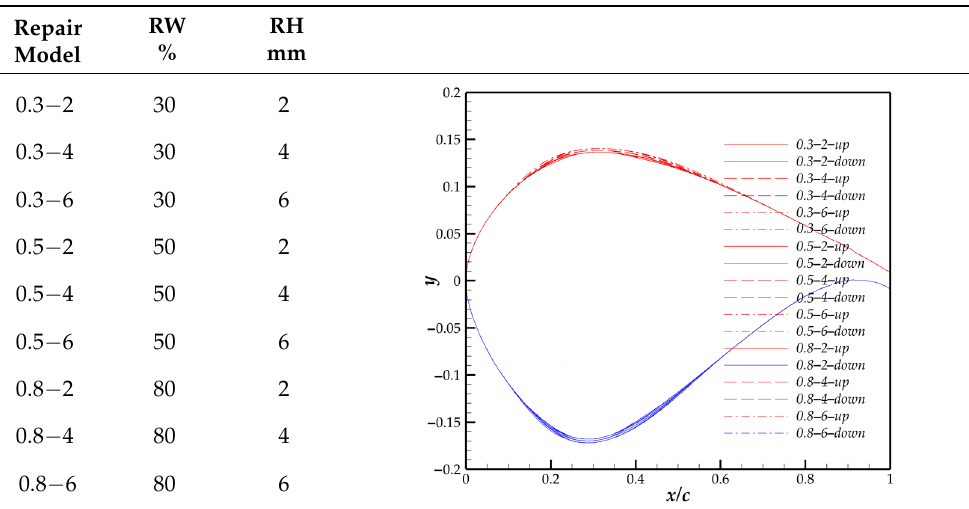
Table 2. Aerodynamic repair analysis model.